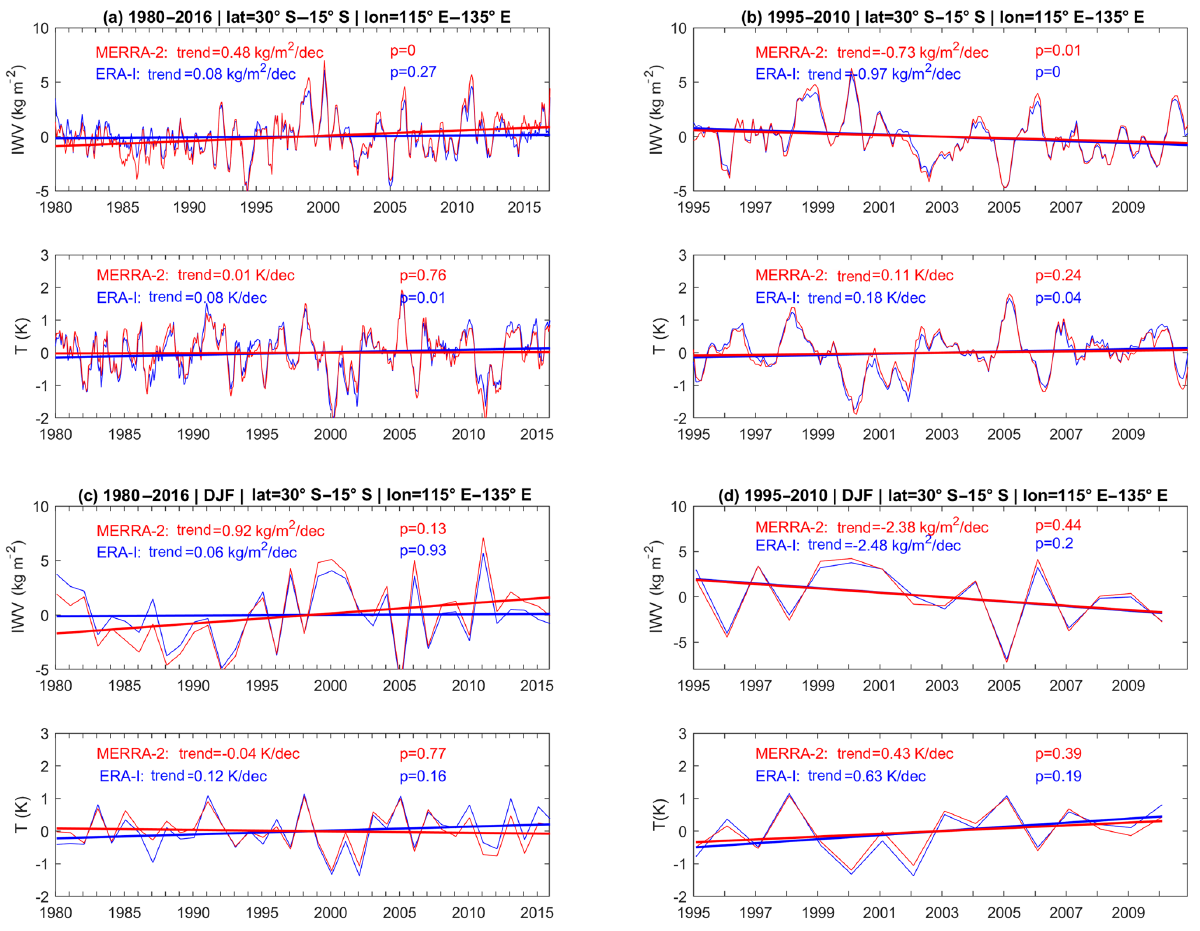
Figure 9. Temperature and IWV anomaly time series for a box over Western Australia (see Fig. 14), using ERA-Interim (blue) and MERRA-2 (red) data, for (a, c) the 1980 to 2016 period, (b, d) the 1995 to 2010 period, and (a, b) the monthly time series and (c, d) the DJF